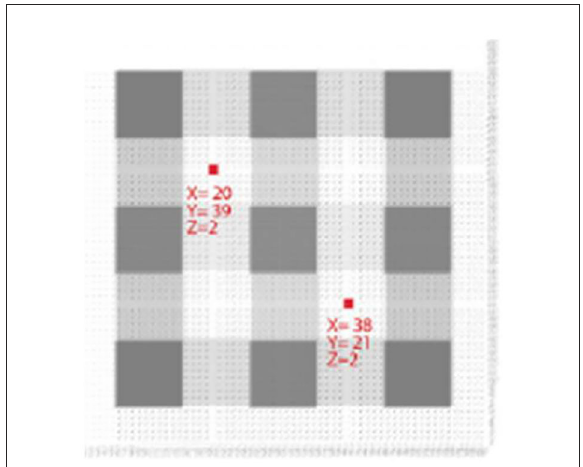
FIGURE2 Schematic representation of the urban block fabric and urban block